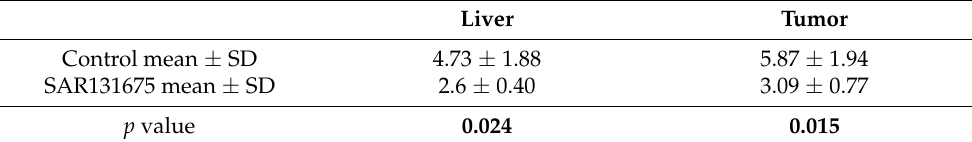
Table 1. Ratio of CD11b + Myeloid cells to CD3 + Lymphocytes in liver and tumor a .